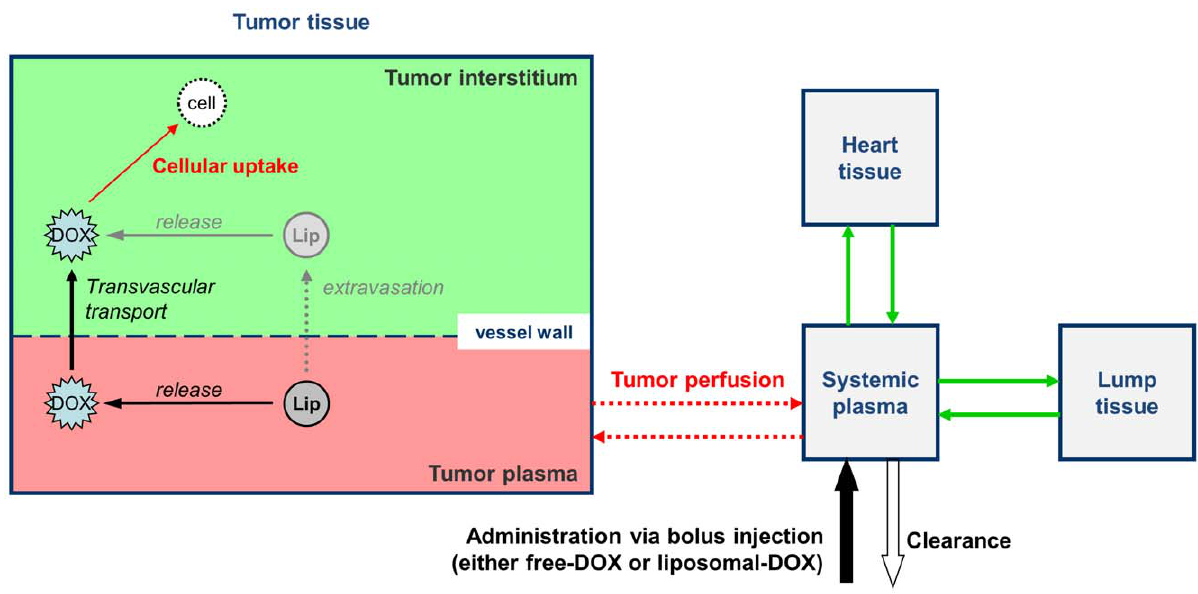
Figure 2. Pharmacokinetic multi-compartment model of DOX and liposome transport. Systemic plasma, heart, and other bodily tissues are modeled as single compartments. Tumor is modeled in more detail including plasma, interstitium (EES), and cells as separate compartments. Transvascular transport of both bioavailable DOX and liposomes is driven by the concentration difference between the tumor plasma and the EES of DOX/liposomes, as well as on the vascular permeability for DOX/liposomes, and vessel on surface